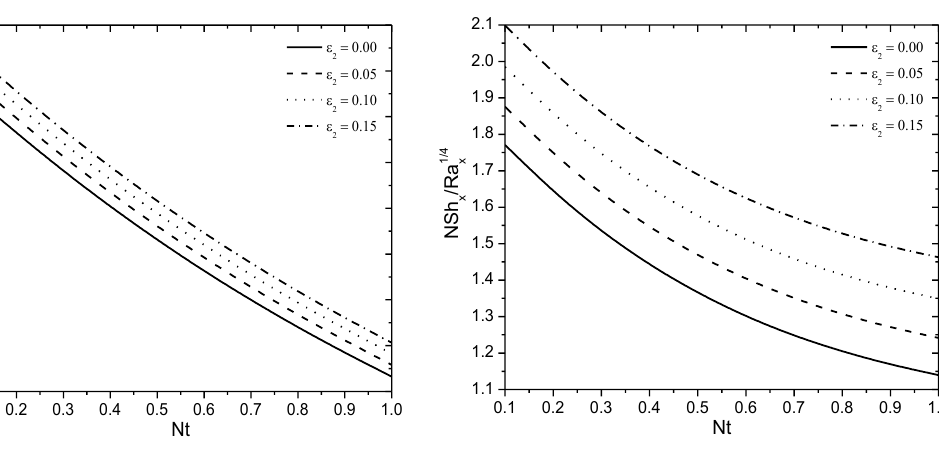
 on the Local nanoparticle 2 Sherwood